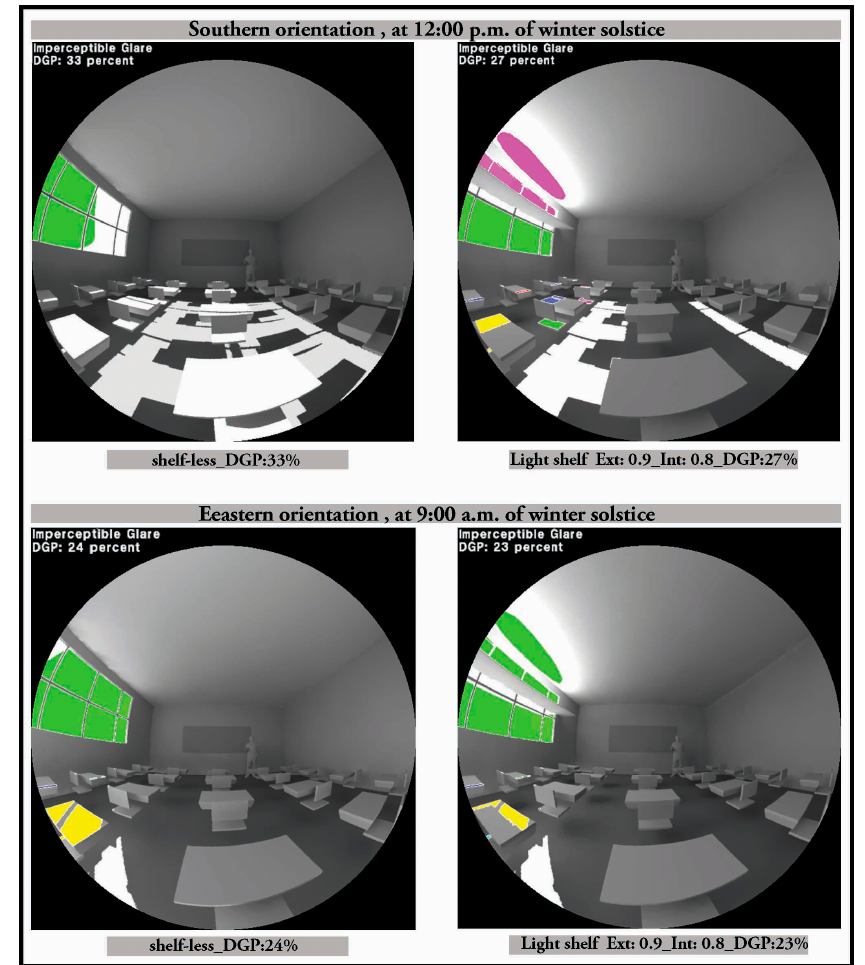
Figure 6. The results of the visual comfort analysis with the DGP index at the middle end part of the room one meter above the floor; southern orientation at 12:00 p.m. of the winter solstice in the upper row; eastern orientation at 9:00 a.m. of the winter solstice in the lower row.